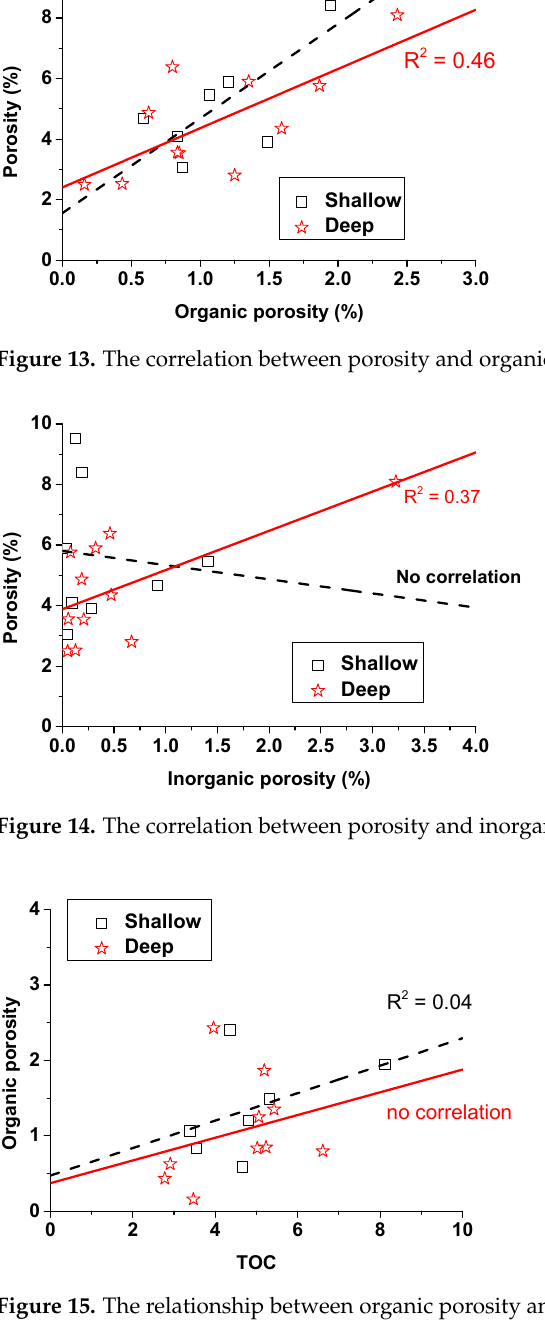
Figure 15. The relationship between organic porosity and TOC.